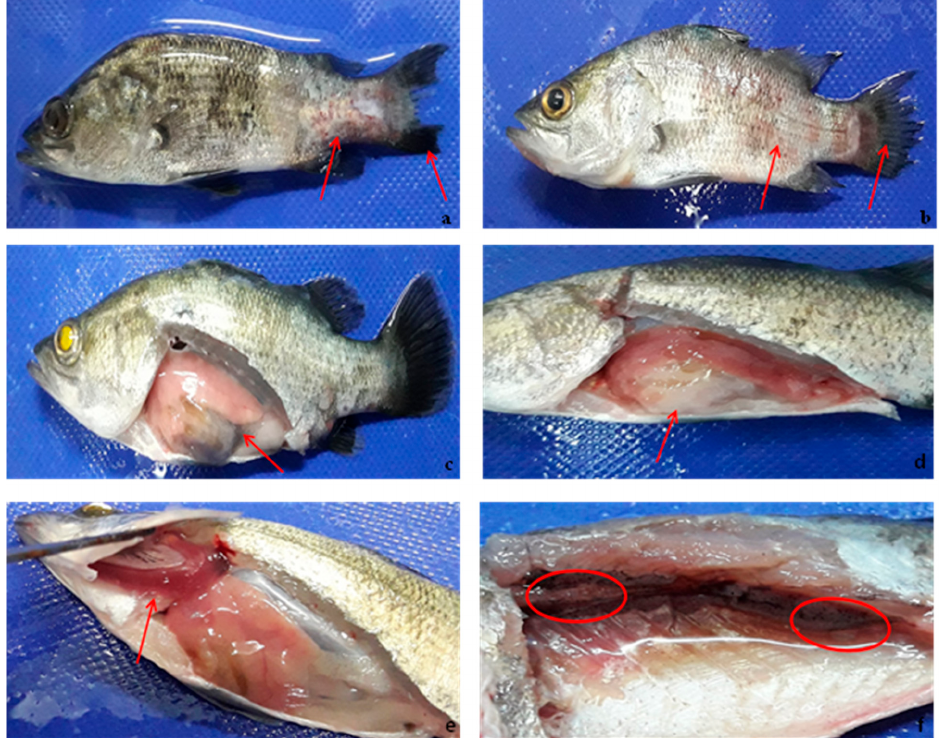
Figure 6. Juvenile seabass experimentally challenged with pathogenic V. harveyi showing ( a , b ) hemorrhagic skin, eye opacity, tail and fin rot, ( c ) Infected and swollen gonad, ( d ) Swollen intestine, ( e ) Pale and discolored of gill, and ( f ) Black spots.